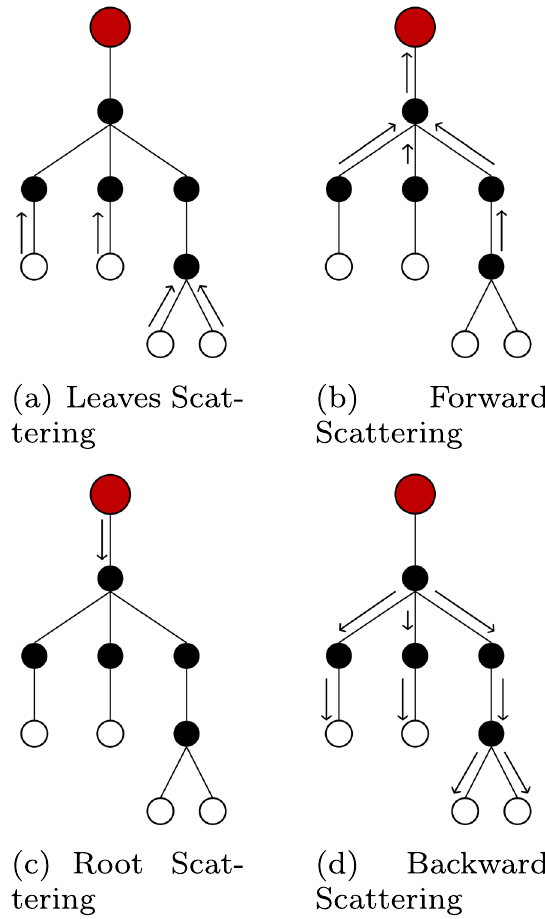
Fig. 4 WD connection tree computational flow. Black elements are nodes, white elements are the leaves. The root is the red